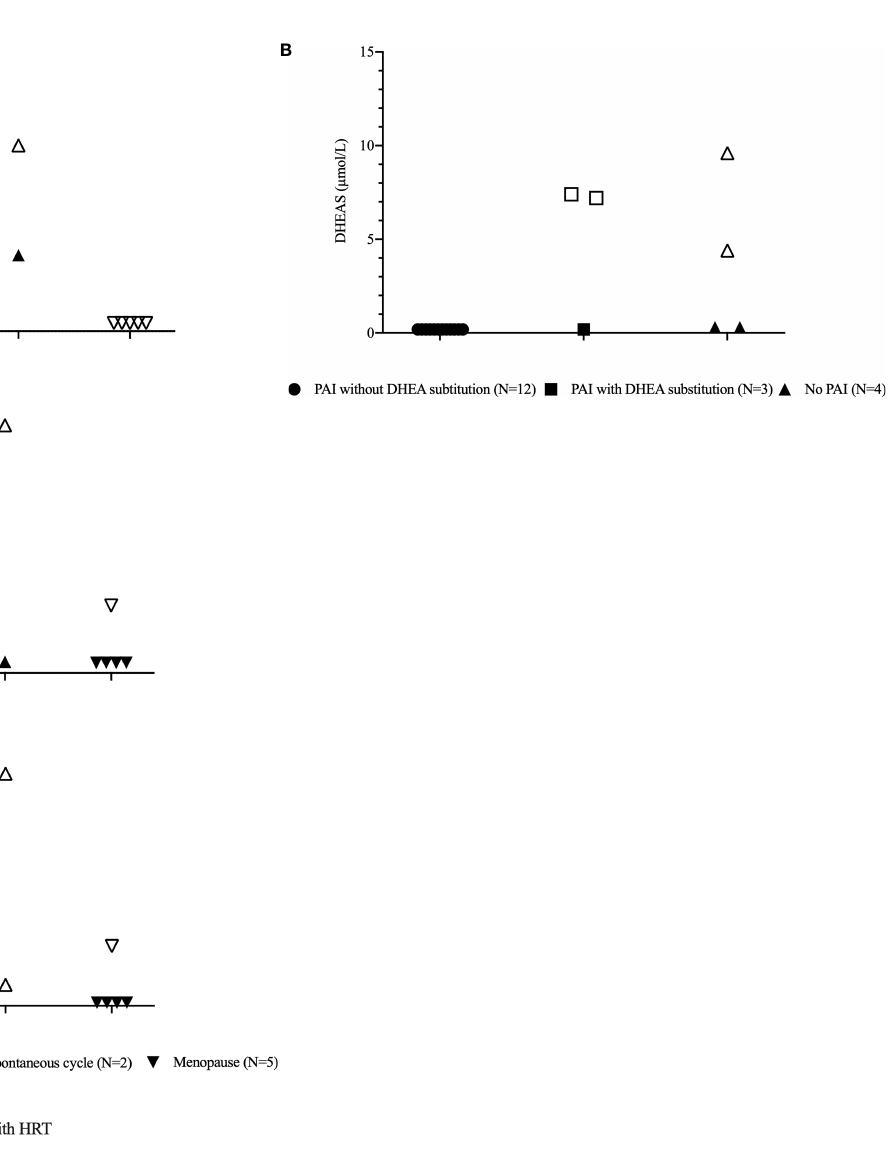
FIGURE 1 | Ovarian and adrenocortical hormones in 19 female patients with APECED. (A) Anti-Müllerian hormone (AMH), androstenedione, and testosterone levels in relation to ovarian function and hormonal replacement therapy (HRT). (B) Dehydroepiandrosteronesulfate (DHEAS) levels in relation to the presence of primary adrenocortical insuf fi ciency (PAI) and use of dehydroepiandrosterone (DHEA) substitution. Values in transparent markings are considered to be within the normal